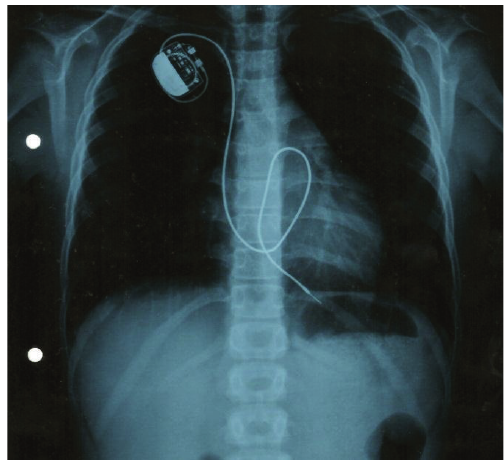
Figure 2: Thorax X-ray after VVI-R implantation.